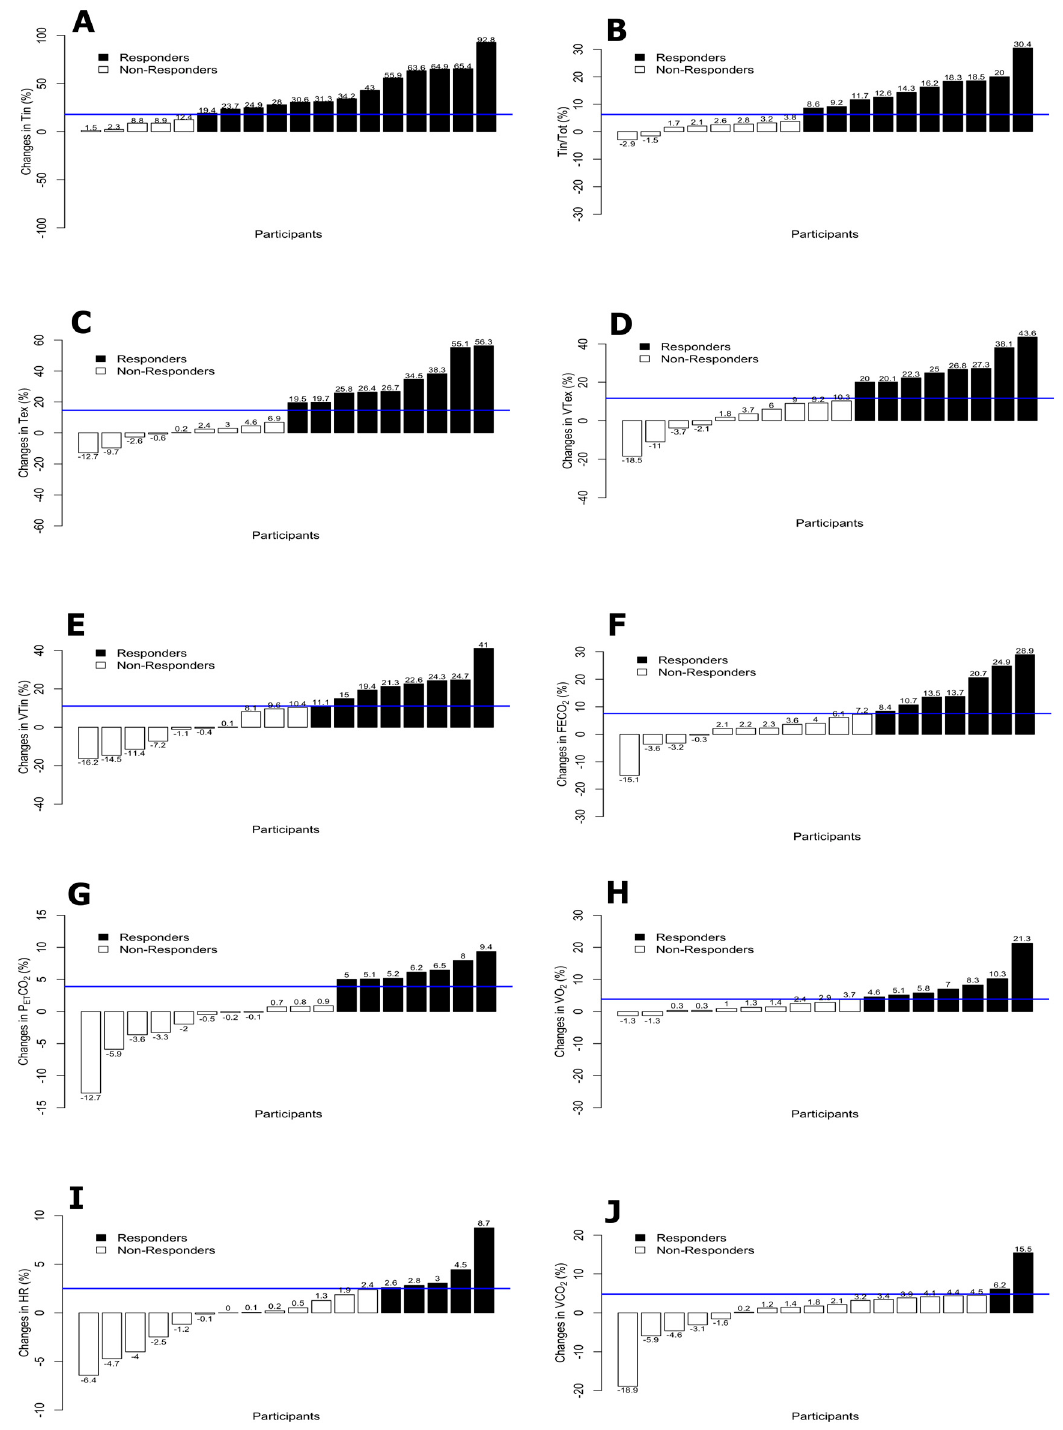
Figure 4. Percentage of change by participants and TE for FB > ONB group variables: Tin ( A ), Tin / Tot ( B ), Tex ( C ), VTex ( D ), VTin ( E ), FECO 2 ( F ), PETCO 2 ( G ), VO 2 ( H ), HR ( I ) and VCO 2 ( J ). Responders vs. non-responders on cardioventilatory variables with higher values in FB.